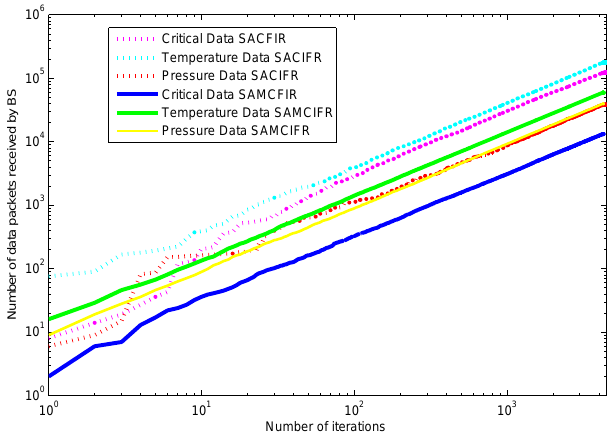
Figure 14. Multi-type data received at BS on network operation in a network of 100 m × 100 m with 100 nodes.